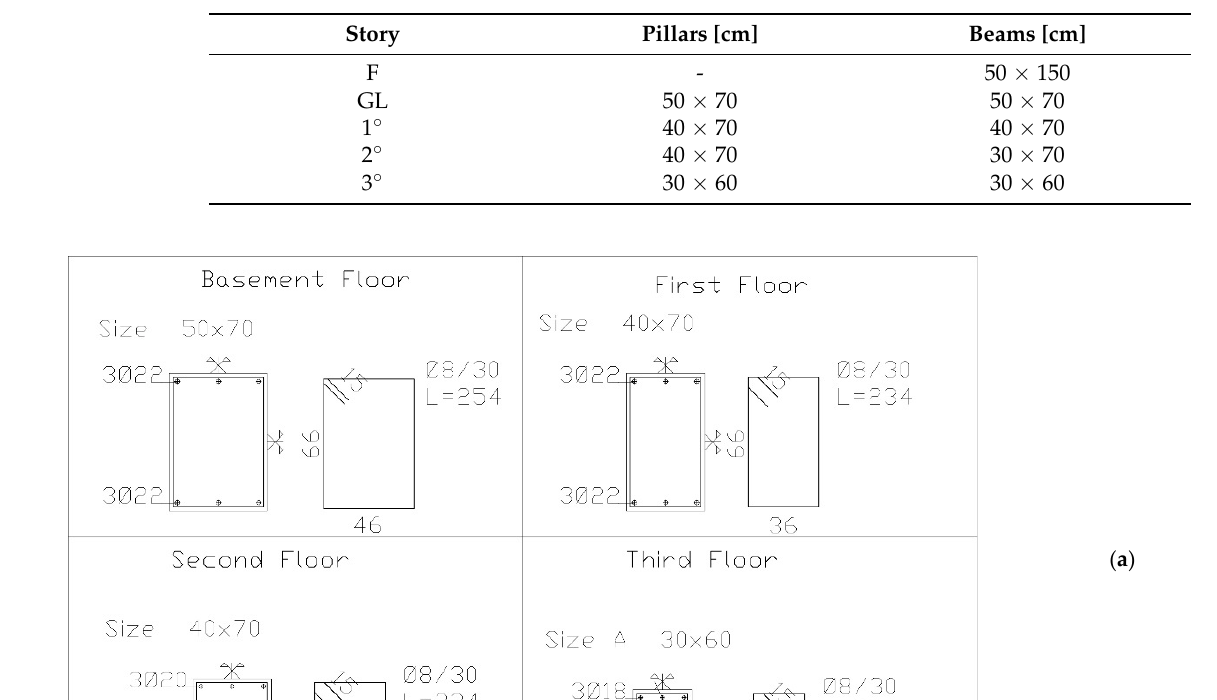
Table 1. Cross-section of load-bearing members. F = foundation level; GL = ground level.